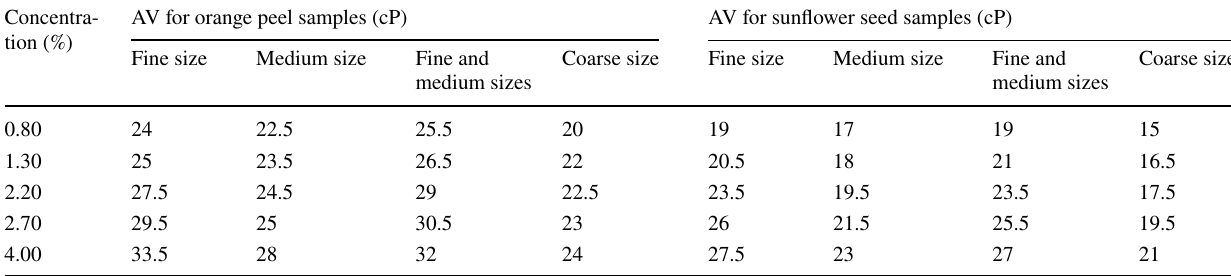
Table 2 Apparent viscosity results for orange peel and sunflower seed samples Concentra- AV for orange peel samples (cP) AV for sunflower seed samples (cP) tion (%) Fine size Medium